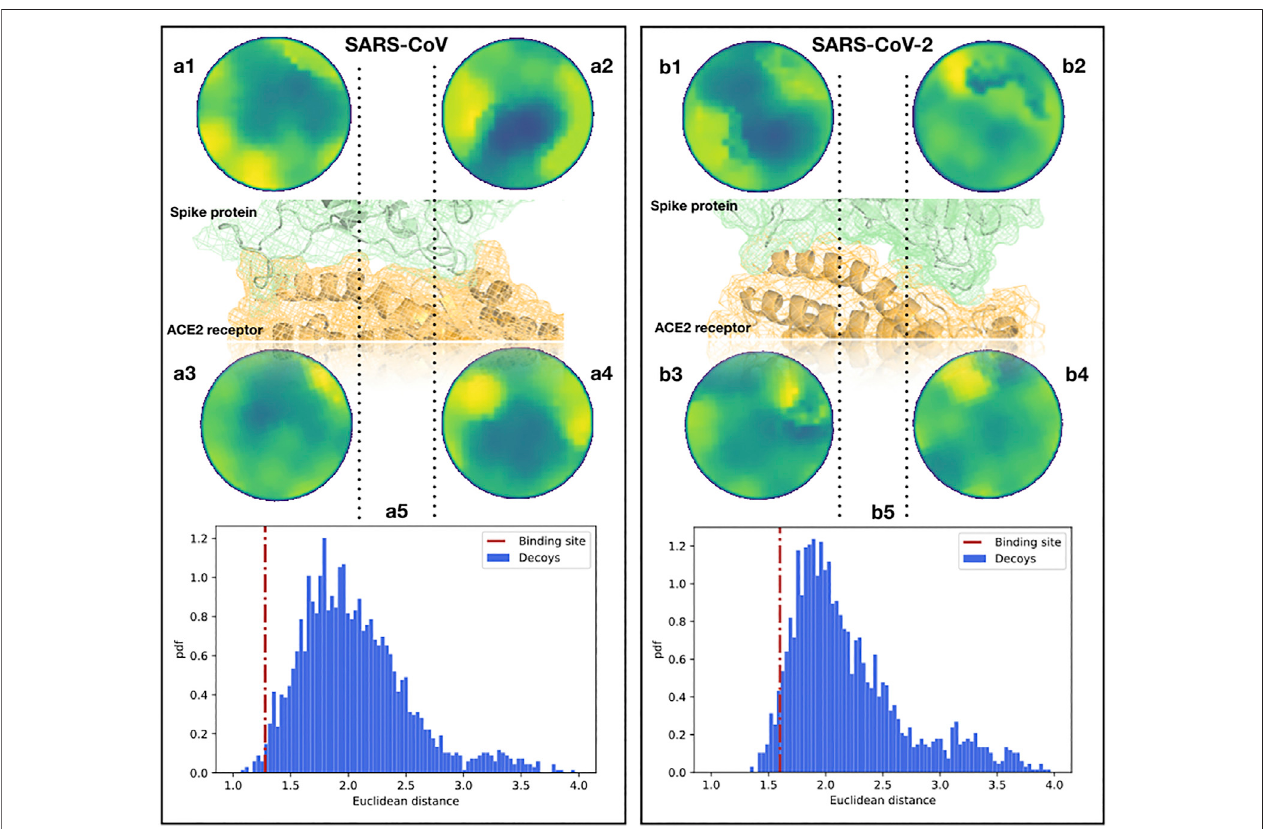
FIGURE 2 | Comparison between the binding regions of the SARS-CoV and SARS-CoV-2 spike protein with human ACE2. (A1,2) Patch projections in the unitary circle (see Section 4 ) for the two ACE2 binding regions of the SARS-CoV spike protein. (A3,4) Patch projections in the unitary circle for the SARS-CoV spike binding regions of the human ACE2 receptor. (A5) Distance distribution between the two SARS-CoV spike binding sites on ACE2 and randomly selected patches on the spike protein of SARS-CoV. Decoy patches are sampled taking two random regions separated by the same distance measured between the centers of the spike-ACE2 binding site identi fi ed in the experimental structure. The red dotted line represents the distance between the real ACE2 and spike patches, calculated from the experimental structure ofthe complex. (B) The sameas (A) but for the binding site of SARS-CoV-2and the human ACE2 receptor. The real distancesare in the fi rst and fi fth percentiles of the distributions for SARS-CoV and SARS-CoV-2, respectively.